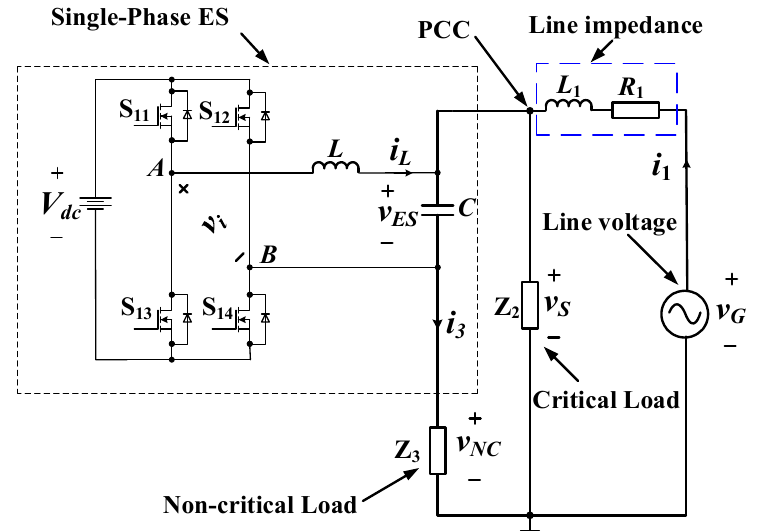
Figure 1. The existing topology and typical application circuit of the single-phase ES.